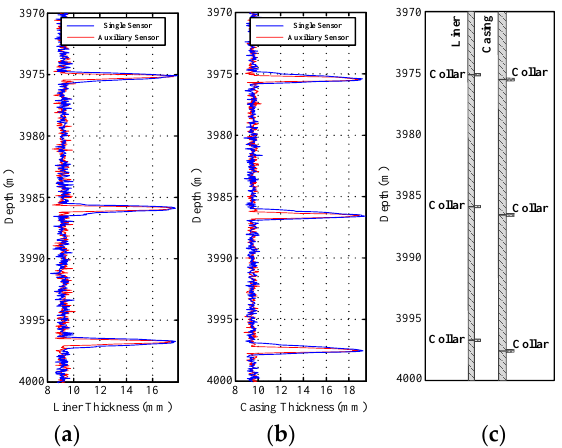
Figure 15. Interpreted thickness using the NDI of two-pipe strings ranging from 3970 to 4000 m: ( a ) liner thickness; ( b ) casing thickness; and ( c ) pipe string structure.